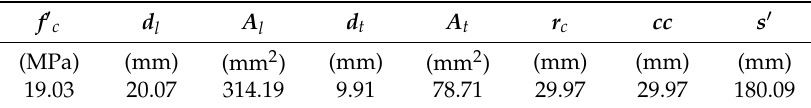
Table 7. Common properties for set 2 specimens.